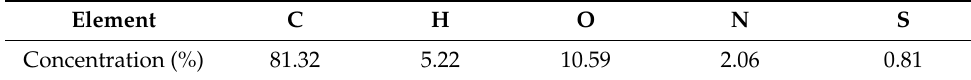
Table 2. The ultimate analysis of the clean coal sample (air-dried basis). Element C H